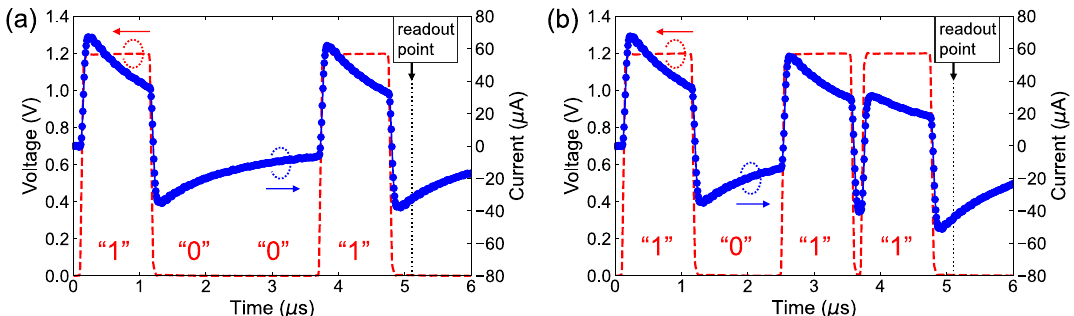
Figure 2. Dynamic current responses of Au/[bmim + ][TFSI − ]/Au to input voltage pulse trains with encoded 4-bit patterns, corresponding to ( a ) “1001” and ( b ) “1011.” Red dashed lines indicate applied voltage and blue circles indicate measured current. Output current ( I out ) is defined as current that is measured at readout point of 300 ns after applying the 4-bit pulse trains.